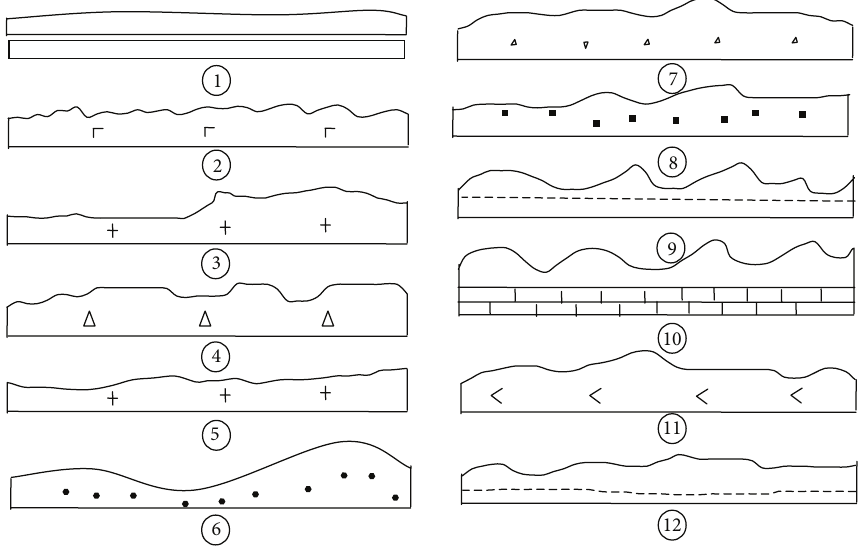
Figure 4: Typical profile curves of joint surface (sample size is 10cm and scale is 1: 2). A Planar and smooth (carbonaceous slate foliation). B Planar and rough (basaltic columnar joint). C Single stepped (coarse-grained granite joint). D Multistepped (volcanic breccia joint). E Slow undulating (fine-grained granite joint). F Undulating (siltstone ripple bedding). G Undulating (breccia-bearing fusion tuff joint). H Undulating (fine-sandstone joint). 0 Compound undulating (calcareous clay rock joint). 1 Compound undulating (calcilutite joint). 2 Planar-undulating (mixed hornblendite joint). 3 Stepped-undulating (calcareous clay rock